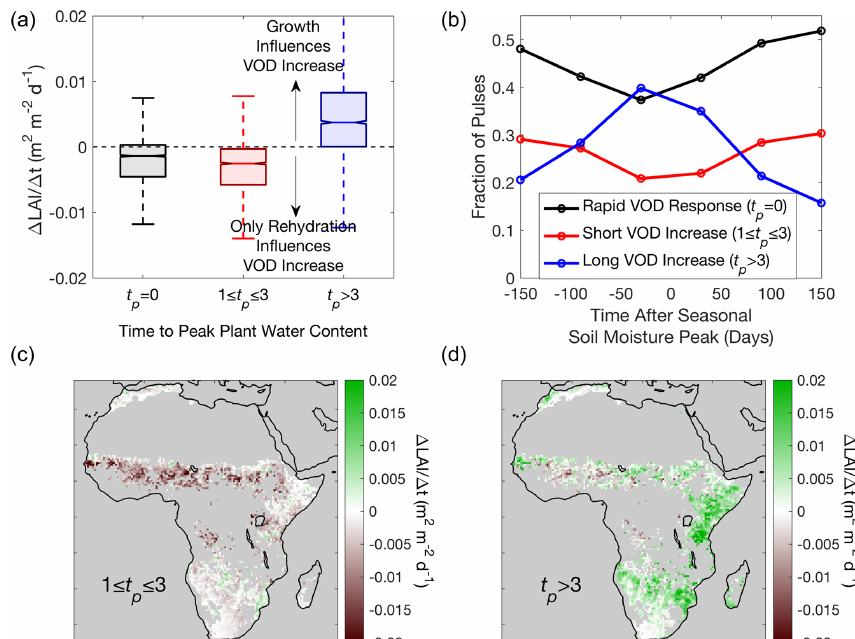
Figure 5. Timescale of plant water content increases in relation to biomass changes and seasonality in African regions with median t p ≥ 1d. Growth influences the plant water uptake timescale when (cid:49) LAI /(cid:49)t > 0. By contrast, only rehydration contributes to plant water content increases when (cid:49) LAI /(cid:49)t < 0. Only intermittent variability in VOD is used to produce t p , removing confounding seasonal connections with LAI (see text and SI). (a) Mean change in LAI per day over length of pulse period binned into rapid responses ( t p = 0), short VOD increases (1 ≤ t p ≤ 3d), and long VOD increases ( t p > 3d). A Kruskal–Wallis test indicates group medians are all significantly different ( p (cid:28) 0 . 01; χ 2 = 2576, υ = 2). Pairwise Mann–Whitney U tests confirm that all pairs are significantly different ( p < 0 . 05). (b) Seasonality of short and long VOD increase occurrences with respect to seasonal soil moisture peak. Positive and negative time indicates occurrence after and before the soil moisture seasonal peak, respectively. Plotted values are spatial medians in 60d sized bins. Sample size in each bin (in a given pixel) is over 100, though pulses tend to be more frequent closer to seasonal soil moisture peak. (c) Spatial distribution of median (cid:49) LAI /(cid:49)t for short VOD increases as binned in (a) . (d) Spatial distribution of median (cid:49) LAI /(cid:49)t for long VOD increases as binned in (a)